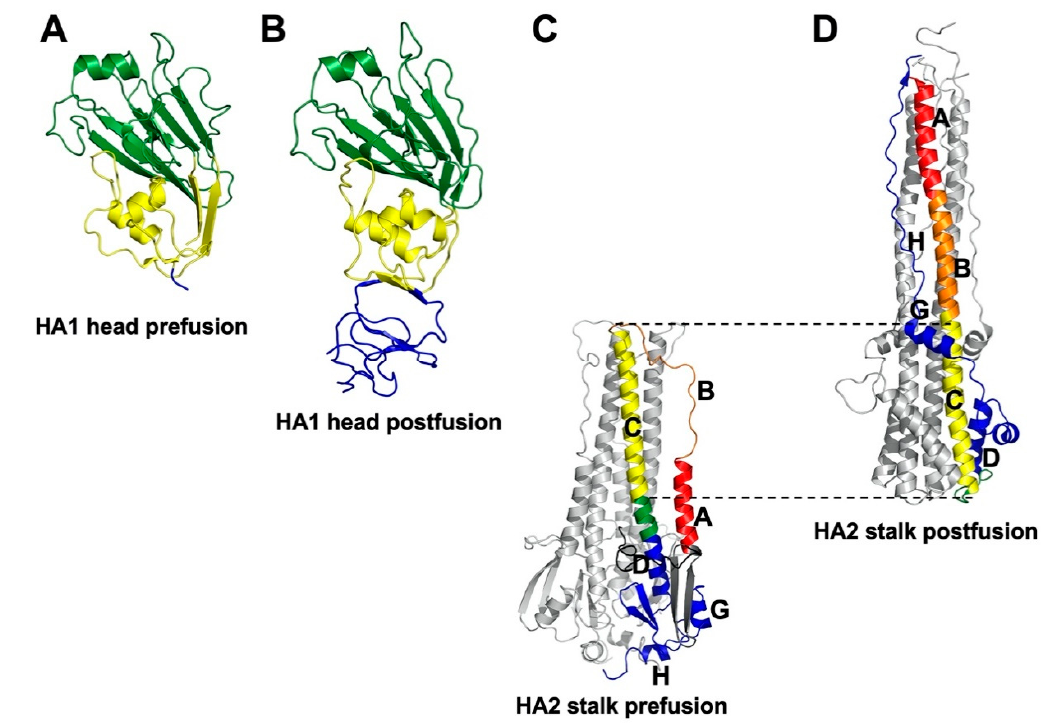
Figure 3. Prefusion and postfusion structures of the HA protein head and stalk. Secondary and tertiary structure is similar in prefusion ( A ) and postfusion ( B ) forms of the head. In panels A and B, the receptor-binding subdomain is colored green, the vestigial esterase subdomain is colored yellow, and portions of HA1 residues in the stalk are colored blue. HA2 residues in the stalk undergo extensive changes in secondary and tertiary structure in prefusion ( C ) and postfusion ( D ) forms. In panels C and D, the following color conventions are used: fusion peptide (black), helix A (red), loop B (orange), helix C (yellow), C–D hinge (green), membrane-proximal residues (blue). Horizontal dotted lines show how helix C is positioned similarly in panels C and D, while other regions such as loop B, the C–D hinge, and the membrane-proximal residues undergo substantial structural changes. The labeling of secondary structure elements in HA is patterned after the X31 low-pH structure [72]. Structures were generated using MacPYMOL using A/CA/04/09 (H1N1) in panel A and X31 (H3N2) in panels B–D. Protein data bank structures are 3MLH, 2VIR, 1HGF, and 1QU1 [73,77,78,101].